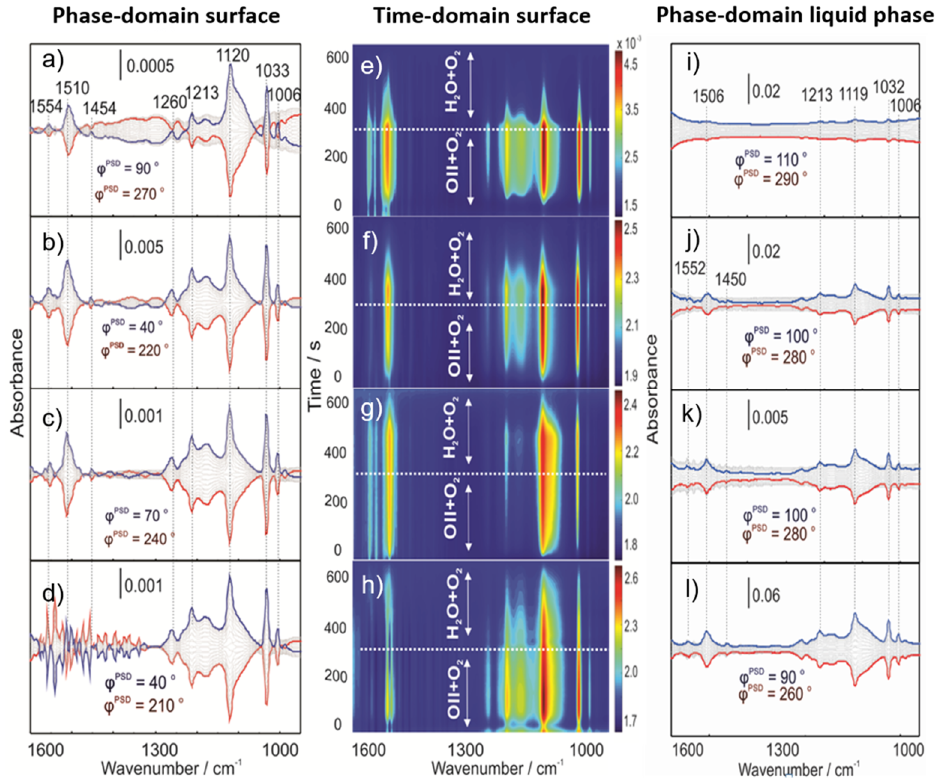
Figure 7. MES-ATR-IR spectra during Orange II concentration modulation over ( a , e , i ) Au-Fe(1:2) / TiO 2 , ( b , f , j ) Au-Fe(1:1) / TiO 2 , ( c , g , k ) Au-Fe(1:0.5) / TiO 2 , and ( d , h , I ) Au / TiO 2 .